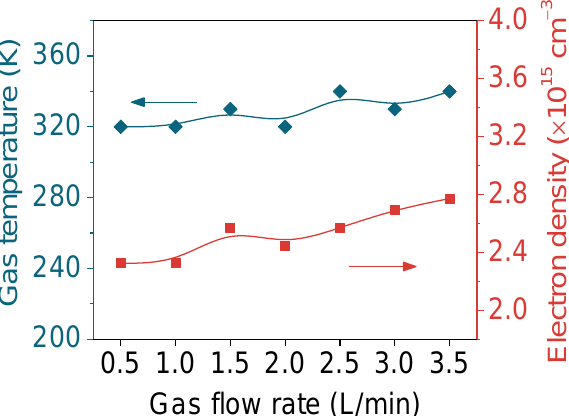
Figure 12. Effects of gas flow rate on gas temperature and electron density.